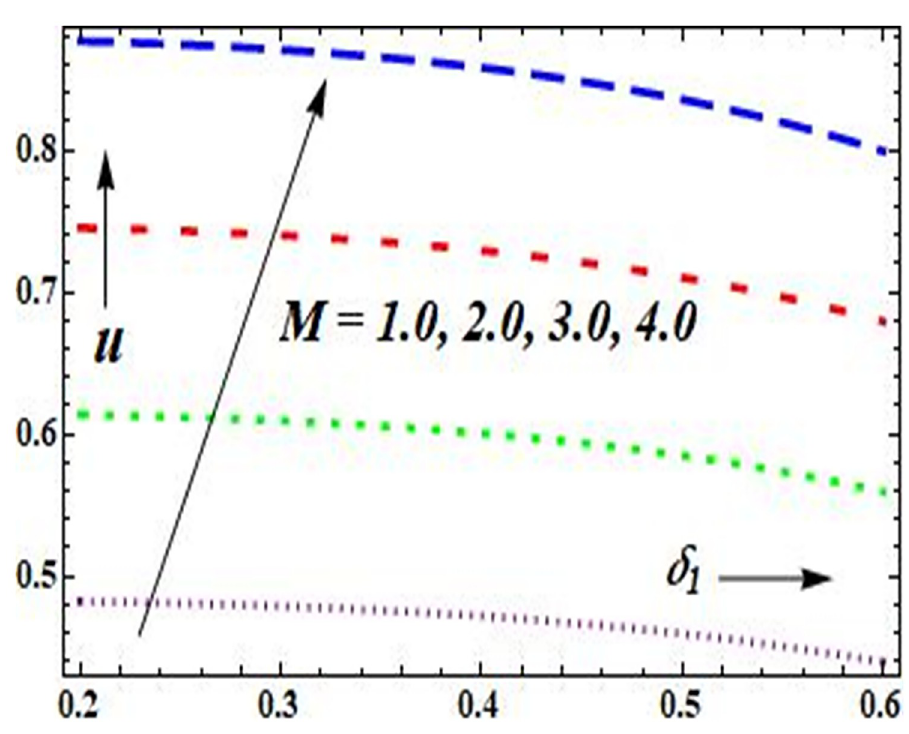
Fig 20. Plot of u on M & δ 1 with ϕ ¼ π